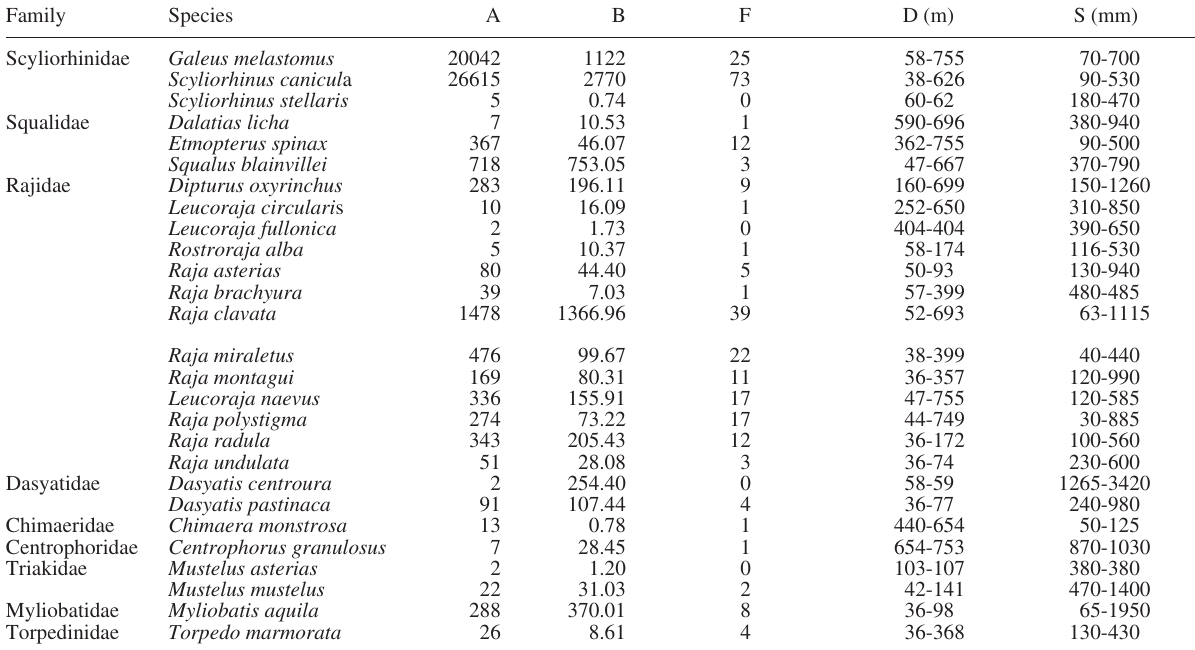
Table 1. – Species caught off the Balearic Islands (western Mediterranean) between depths of 36 m and 755 m. Total abundance (A: number of specimens) and biomass (B: kg), frequency of occurrence (F), depth range (D: m) and size range (S: mm) are shown by species for each surveyed